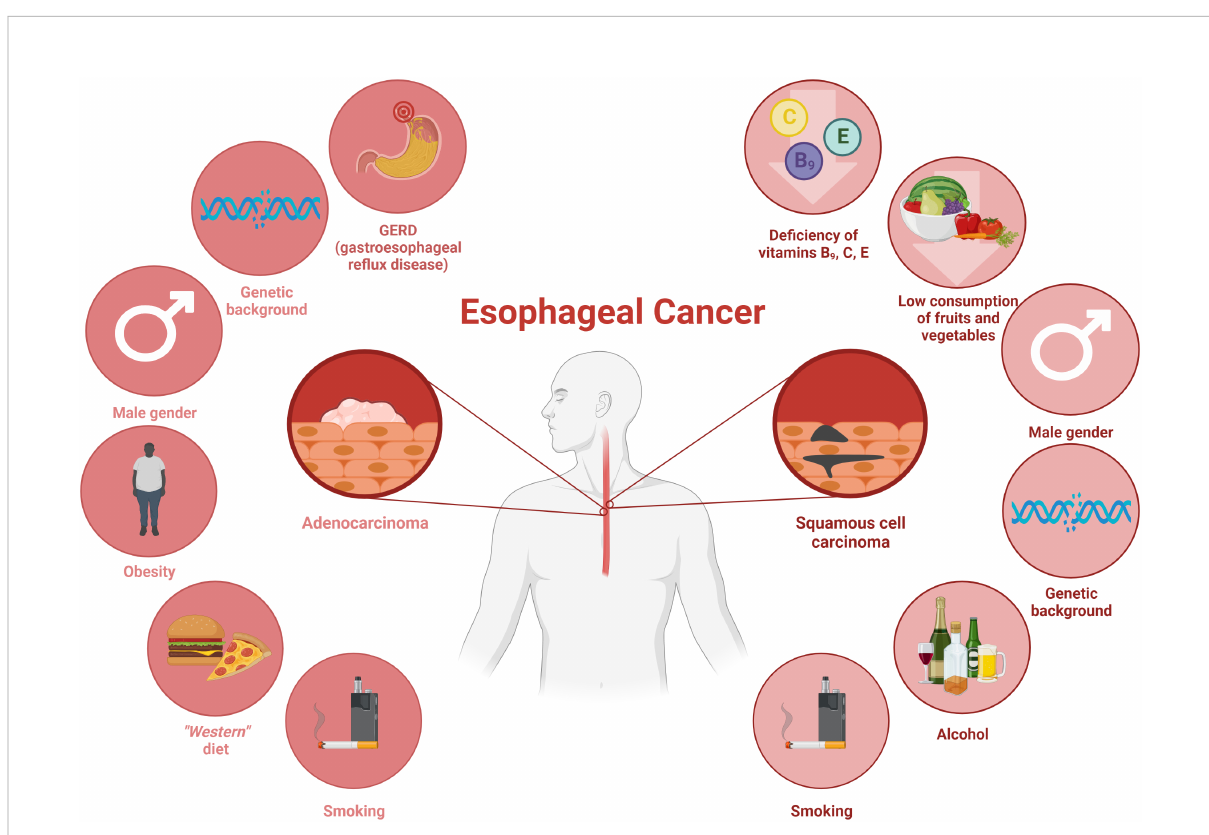
FIGURE 1 The main risk factors contributing to the development of esophageal cancers: adenocarcinoma and squamous cell carcinoma. Own elaboration based on the literature (Parent et al., 2000; Domper Arnal et al., 2015; Clin et al., 2017; Coleman et al., 2018; Huang and Yu, 2018). This fi gure was created with Biorender.com